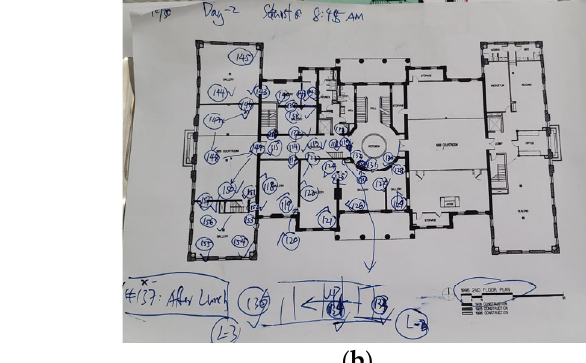
Figure 21. TLS survey of the OPCC: ( a ) laser scanning from the 3rd floor balcony of the 1908 court ‐ room; ( b ) field notes maintained to corroborate scan locations.